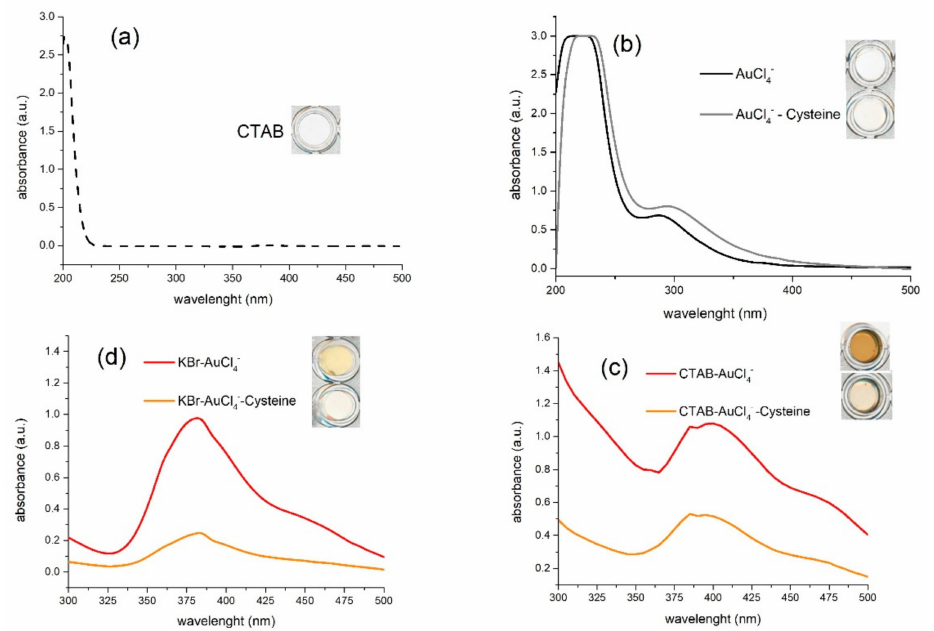
Figure 1. Color and UV-Vis absorbance spectra of ( a ) the CTAB solution (10 mM); ( b ) 0.25 mM AuCl 4 − solutions in the absence and presence of 50 µ M Cys; ( c ) 0.25 mM AuCl 4 − and 10 mM KBr solutions in the absence and presence of 50 µ M Cys; ( d ) 0.25 mM AuCl 4 − and 10 mM CTAB solutions in the absence and presence of 50 µ M